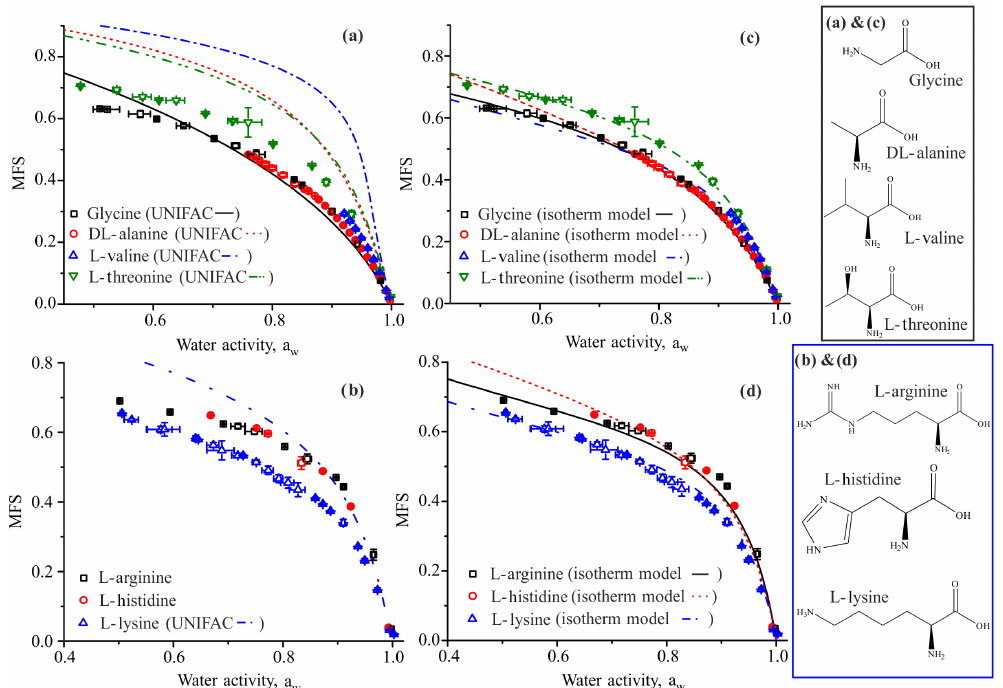
Figure 8. Equilibrium hygroscopicity curves (a) for structurally similar amino acids with different substituents alongside UNIFAC predic- tions. (b) Equilibrium hygroscopicity curves of amino acids with the same O:C ratio (0.33), with UNIFAC predictions generated using E-AIM model III. (c, d) The same amino acids as (a, b) , respectively, presented alongside thermodynamic predictions using the isotherm model discussed in Dutcher et al. (2013), with coefficients available in Table